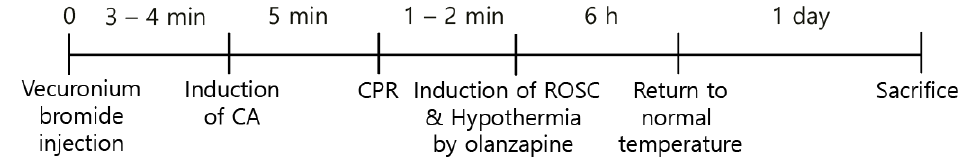
Figure 1. Experimental design for the induction of CA, ROSC, and olanzapine-induced TH.